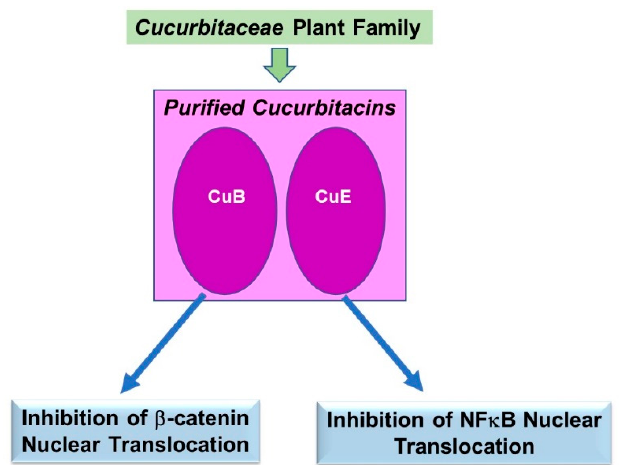
Figure 6. A schematic summary of the effects of metabolites from Cucurbitaceae on protein trafficking dynamics.